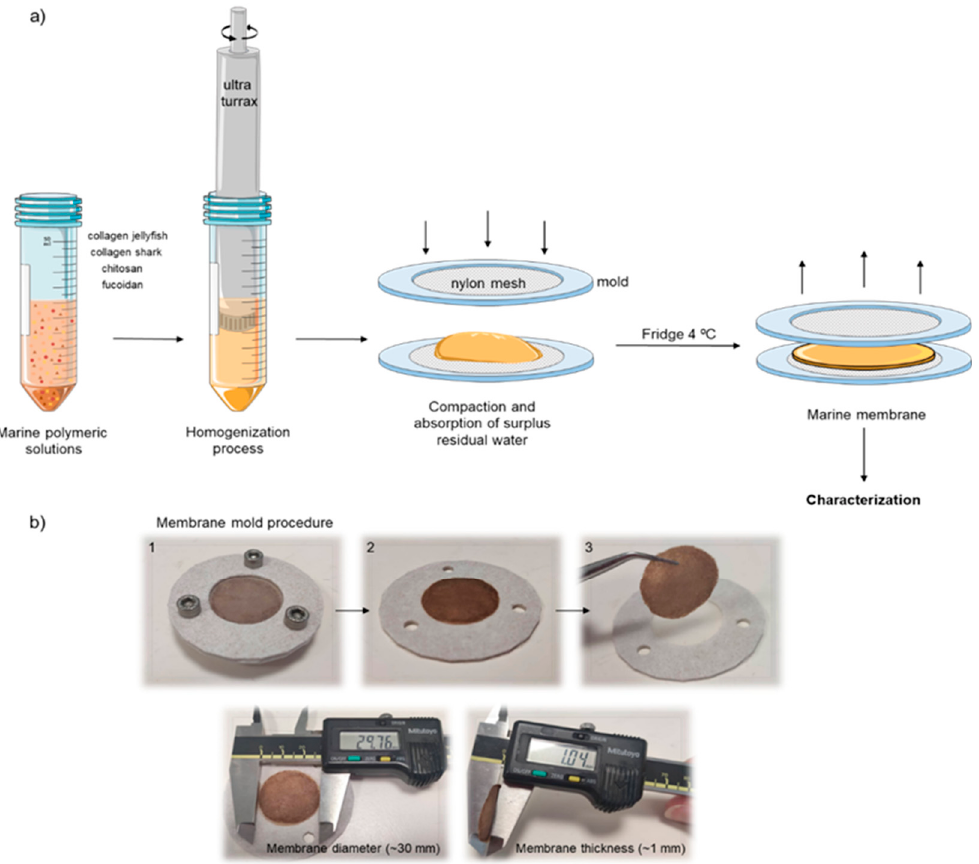
Figure 12. Preparation of marine biopolymers membrane. ( a ) Schematic representation of biomaterial-membrane formation process using a 3D printed PLA mold comprising a nylon mesh, where the biopolymers blend is placed and compacted while removing the excess of solvent; ( b ) Representative images of the molding procedure, the produced membranes and the respective dimensions.